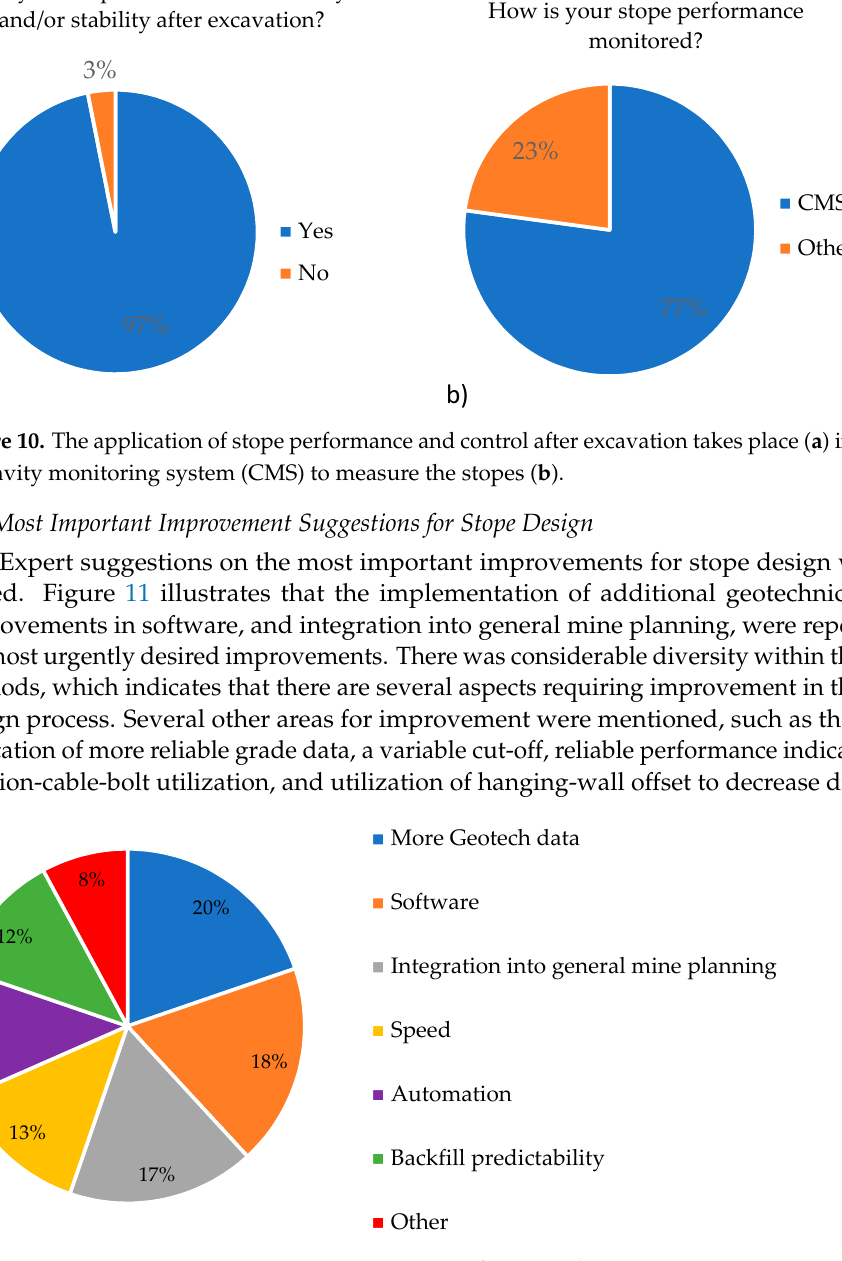
Figure 11. Most important improvement suggestions for stope design.